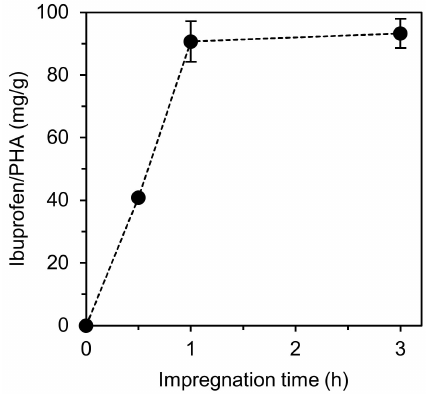
Figure 4. Maximum ibuprofen concentration on mcl-PHA vs. impregnation time for the experiments conducted at 20 MPa and 40 ◦